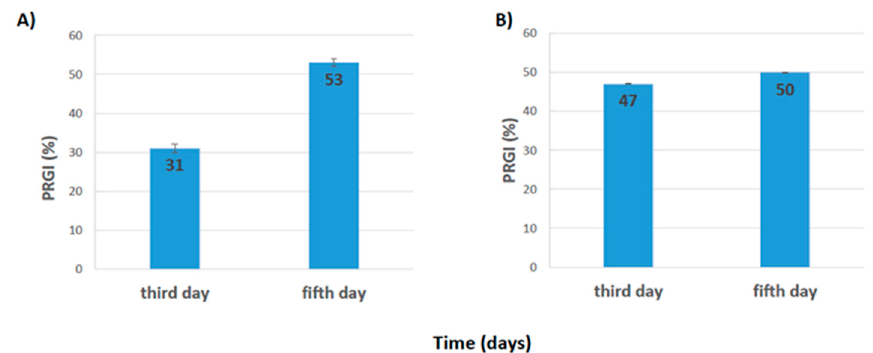
Figure 4. Inhibition percentage growth of pathogen F. chlamydosporum ( A ) and A. brassicicola (B) against C. virescens after three and five days of inoculation in dual culture on OA medium, respectively. Mean and standard deviation is expressed in the error bar (n = 5).